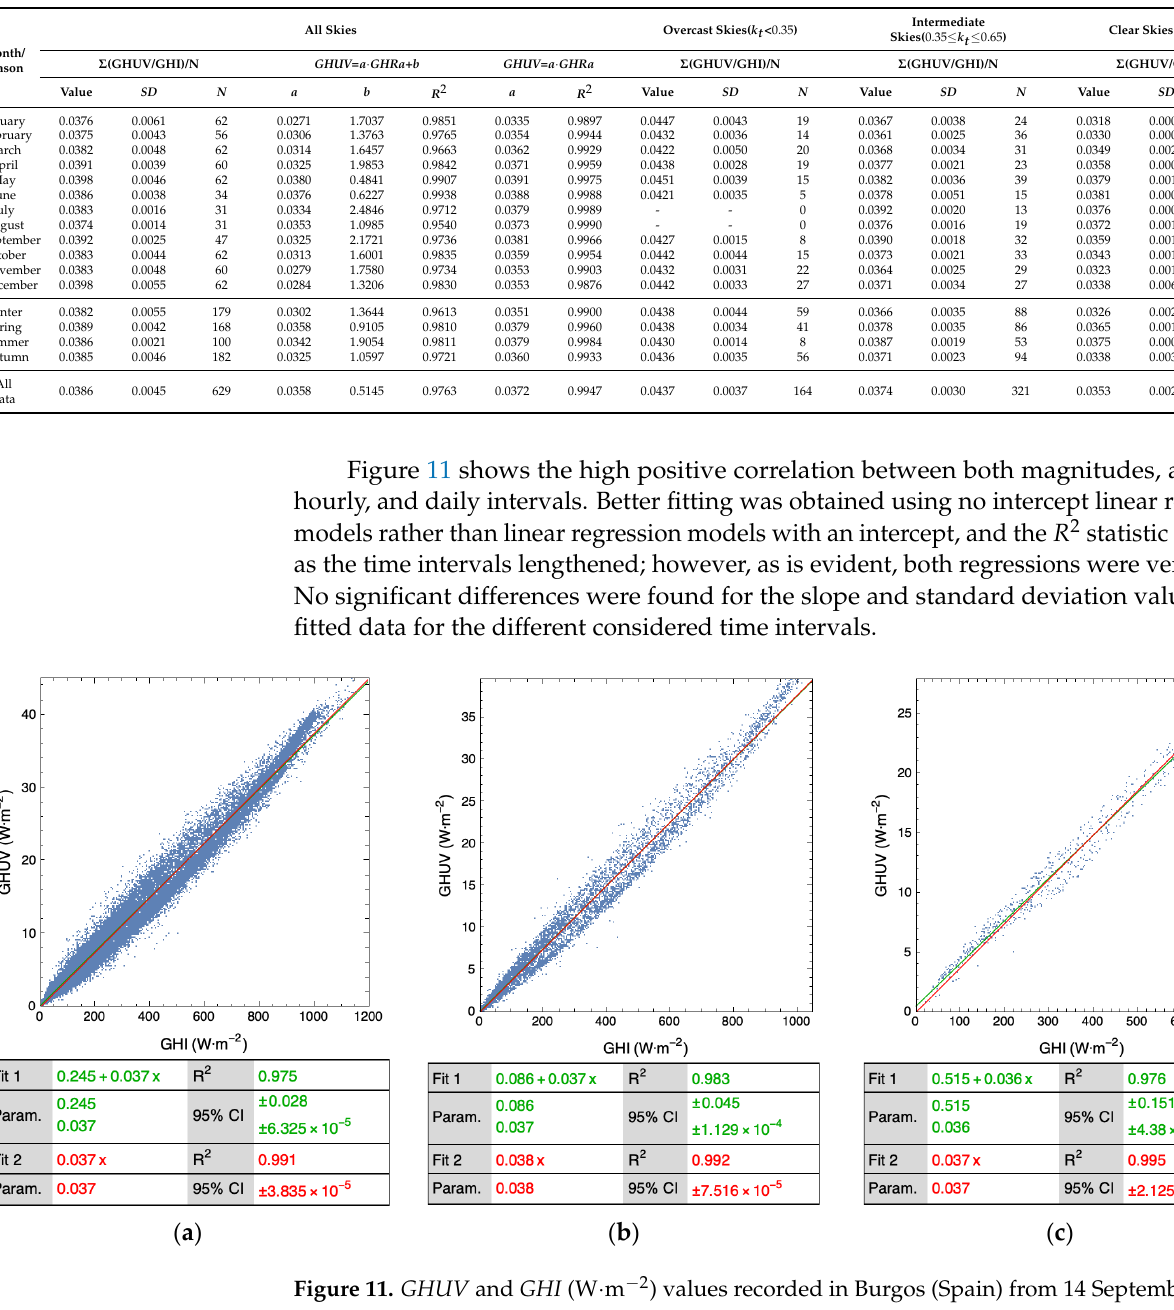
Table 9. Monthly, seasonal, and total GHUV/GHI average values, number of daily values (N) and standard deviations (SD) under different sky conditions, together with the slope (a), offset (b), and R 2 values of the linear regressions GHUV = a · GHI + b and GHUV = a · GHI .